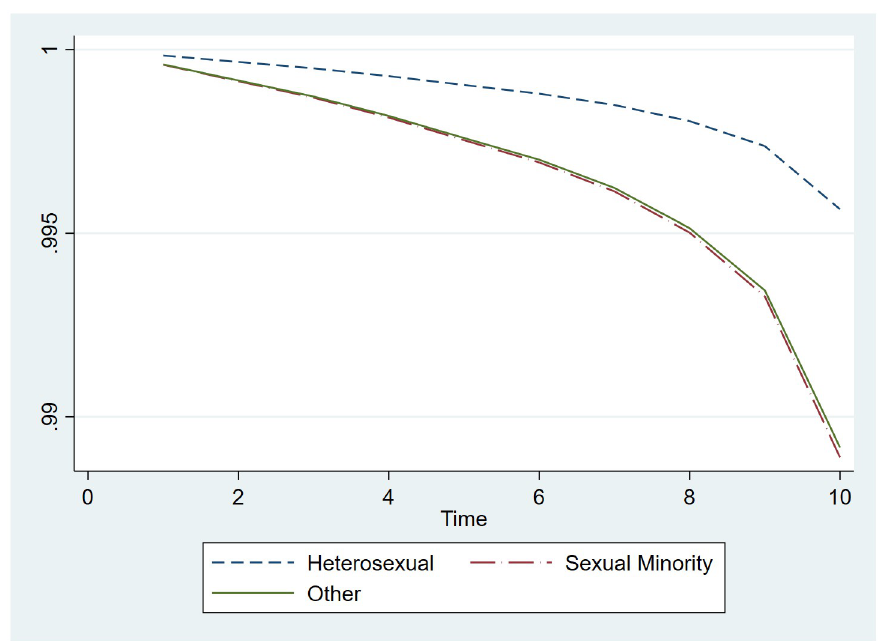
Fig 2. Cox regression curves modeling time to SRB event for men by sexual orientation.